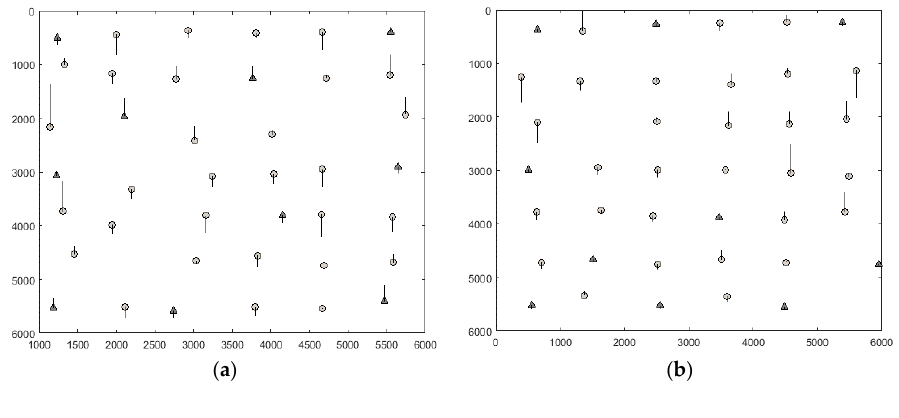
Figure 8. Vertical parallax of CIPs on the normalized scenes in Experiments 2, 6, and